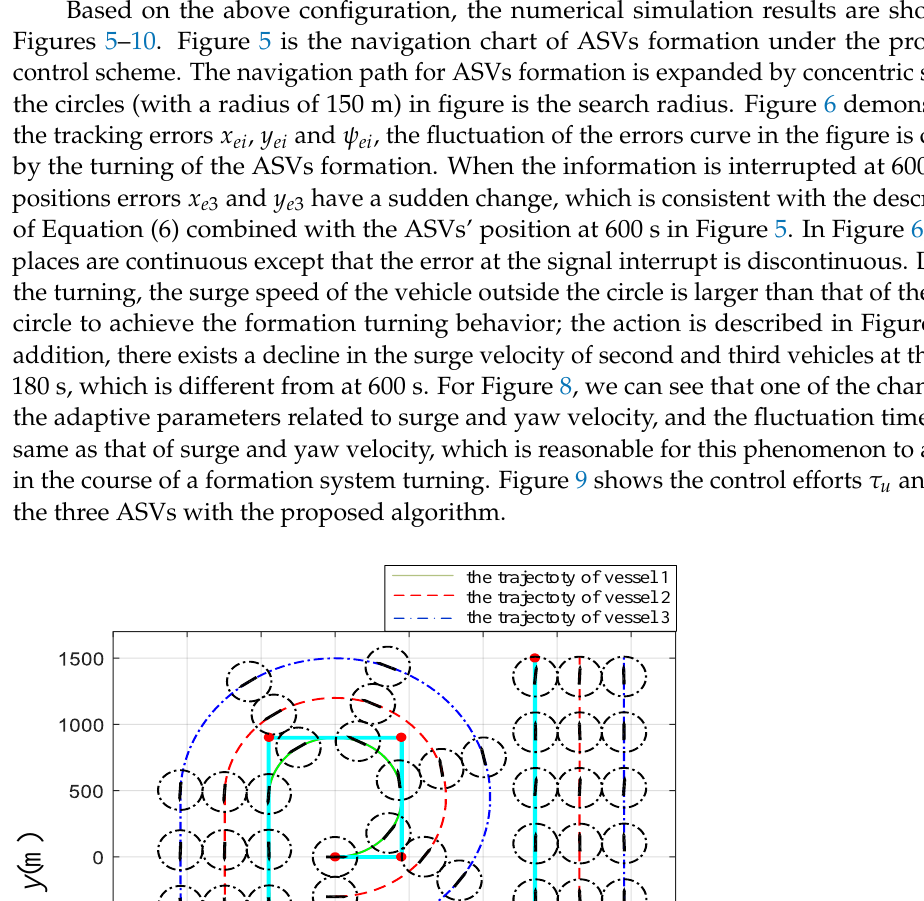
Table 1. Controller parameters for the controller.